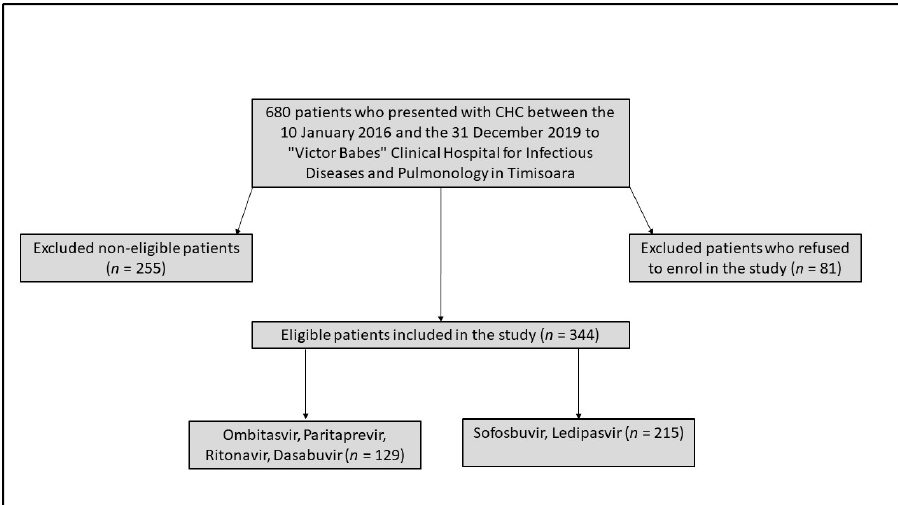
Figure 1. Flowchart of patient recruitment.